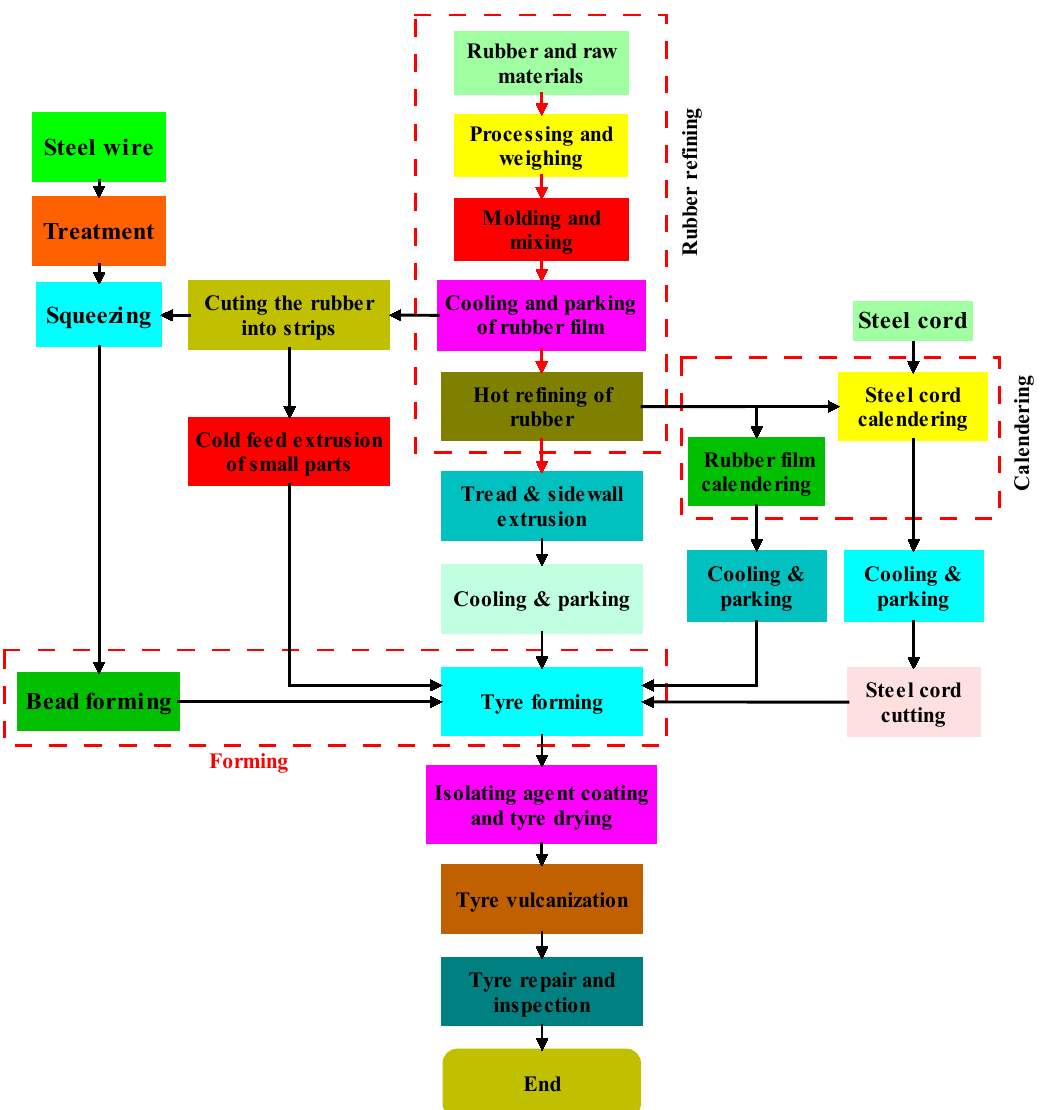
Figure 5. Technological process of radial tire casing.